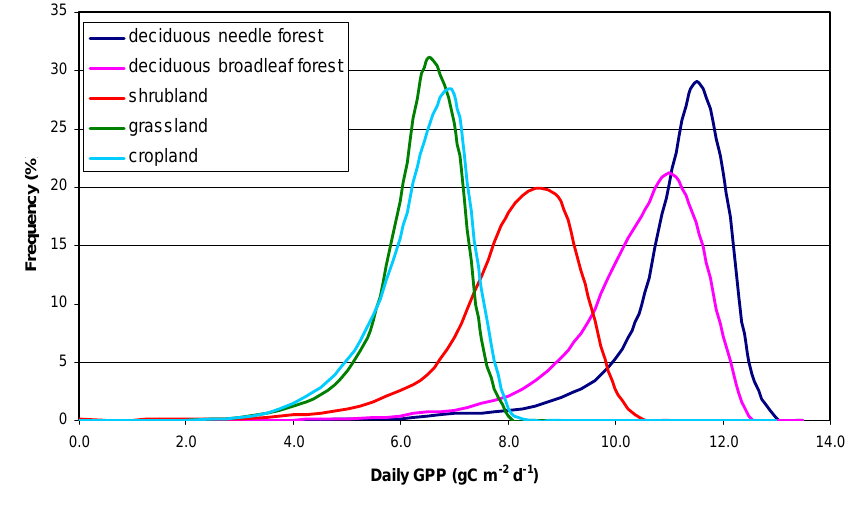
Figure 4. Frequency distribution for daily GPP (gC·m -2 ·day- 1 ) per biome type over the Netherlands for June 24, 2008.